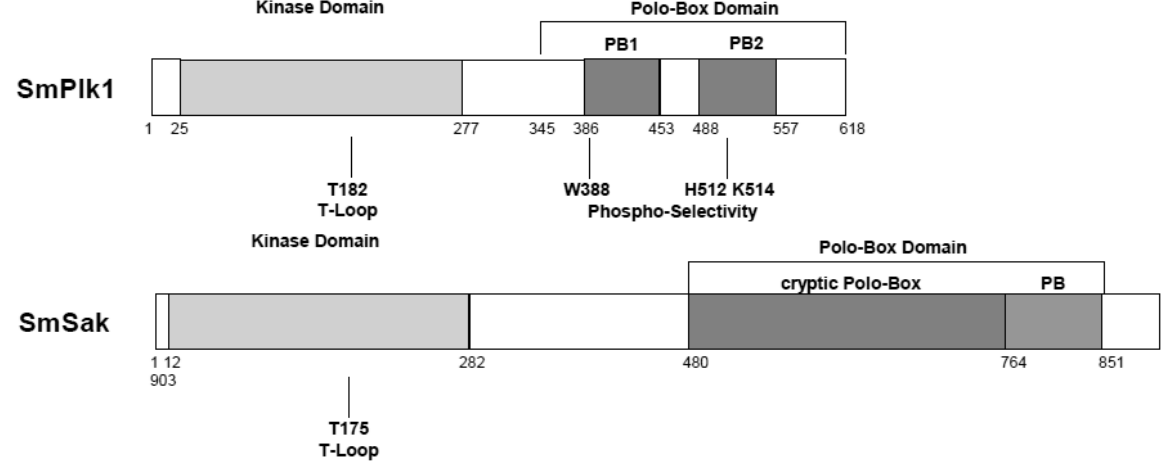
Fig. 2 – Schematic representation of the two S. mansoni polo-like kinases . SmPlk1 is similar to other Plk1 proteins composed of a conserved N-terminal kinase domain containing in its activation T-loop the conserved Threonine residue (T182) whose phosphorylation is required for activation, and in its C-terminal part a polo-box domain composed of two conserved polo-boxes (PB1 and PB2) containing the three amino-acids (W388, H512 and K514) involved in the binding to specific phosphosubstrates. SmSak is a second Plk of S.mansoni and similar to the divergent member of the Plk family, Plk4 also named Sak. Its kinase domain contains the phosphorylable T175 residue in the activation T-loop, and its C-terminal part is characteristic of Plk4/Sak proteins formed by a single polo-box and a cryptic polo-box. Numbers indicate the position of amino acids in the protein